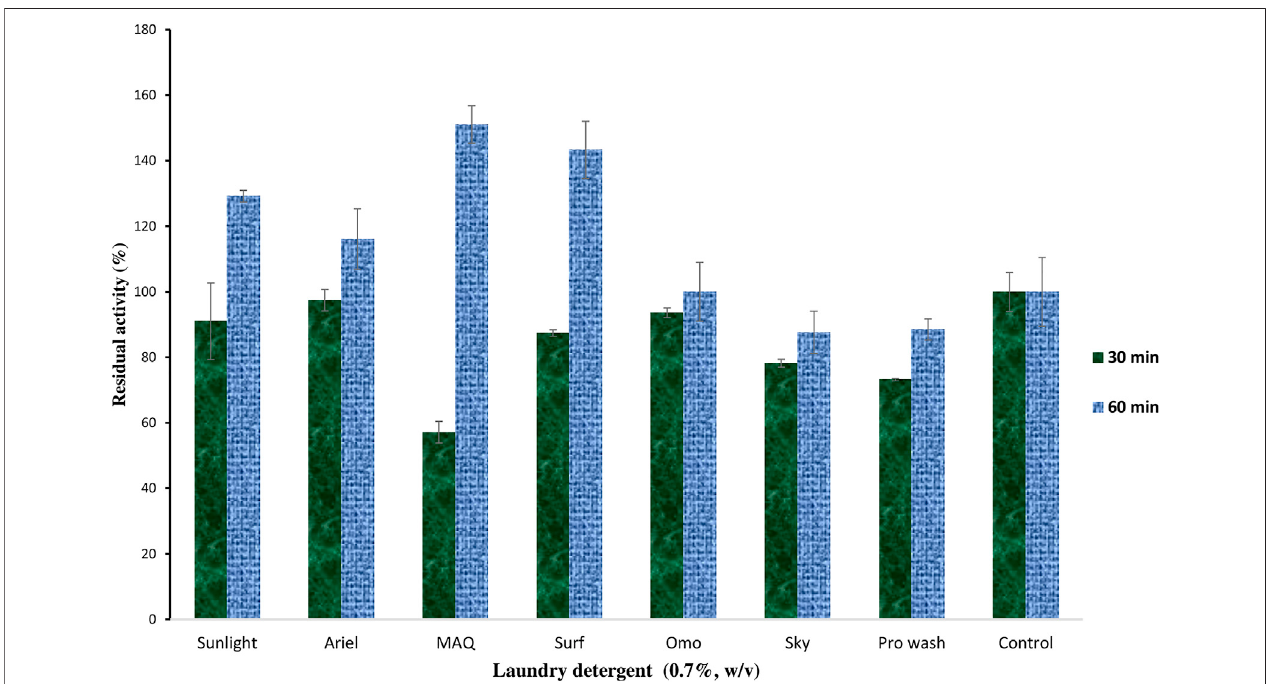
FIGURE 4 | The impact of some selected laundry detergents on the catalytic ef fi ciency of keratinase from C. aquifrigidense FANN1.